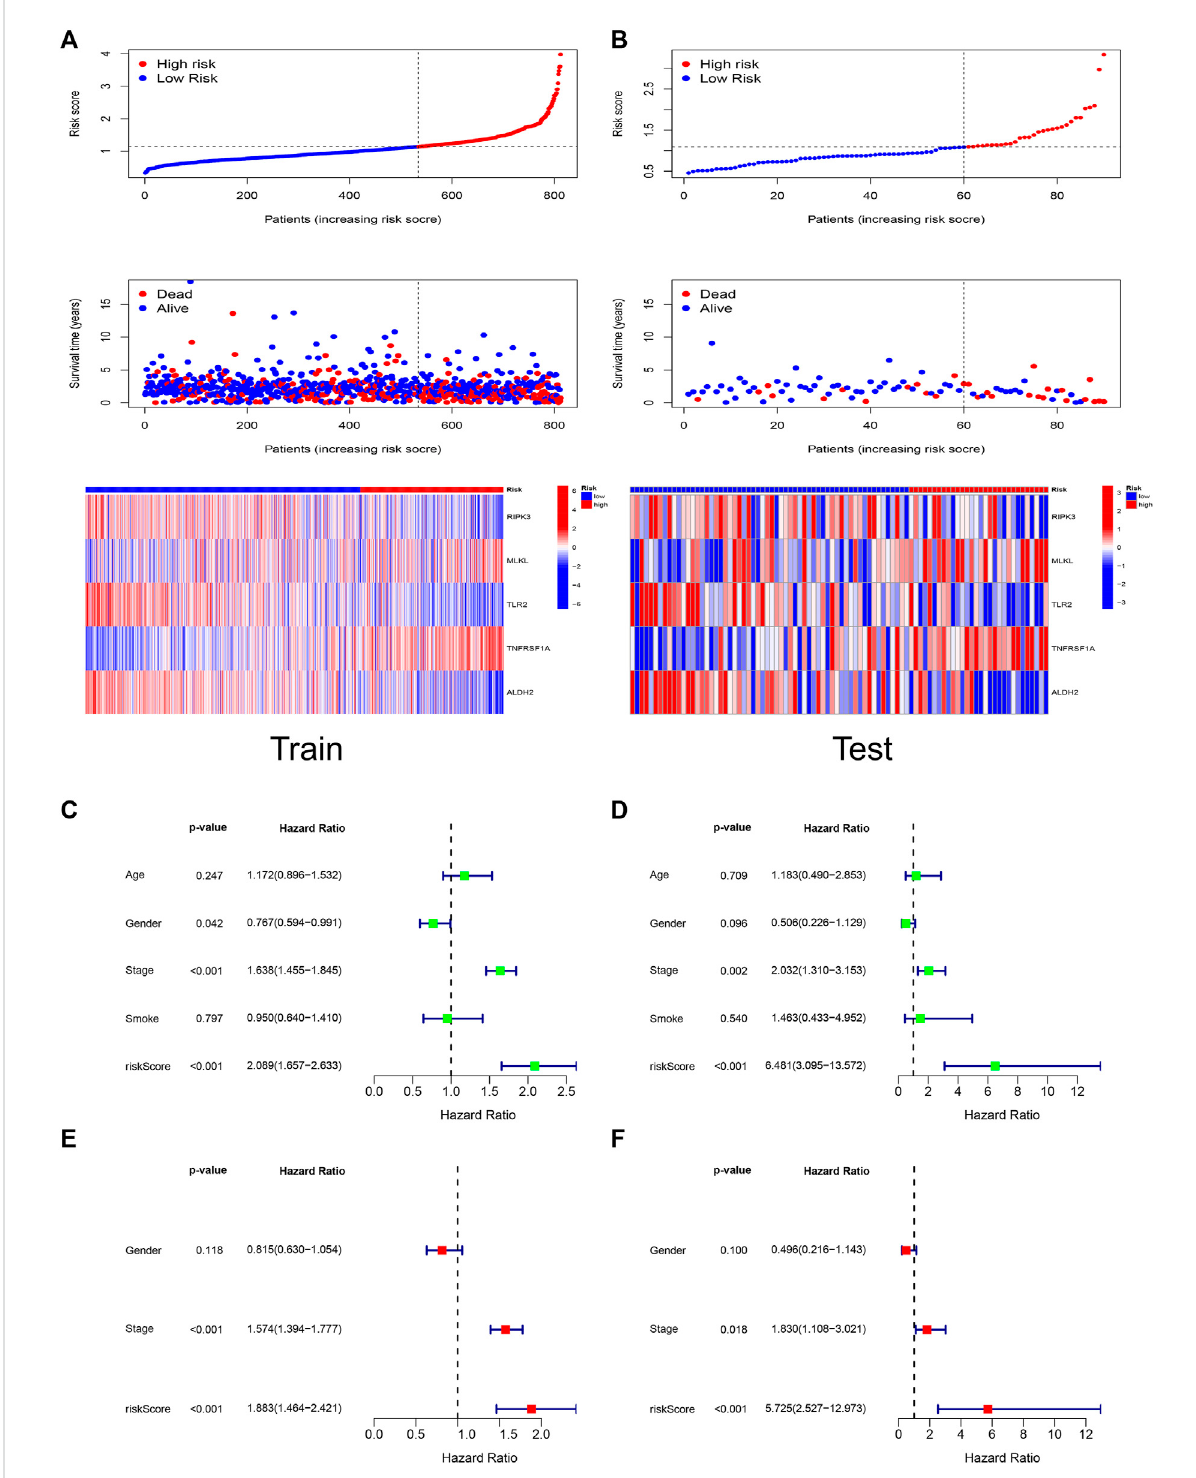
FIGURE 4 Risk score has independent prognostic signi fi cance. The trends of risk scores, the distribution of survival status, and the expression of the fi ve genes included in the signature in Train set (A) and Test set (B) . The prognostic ability and clinical characteristics of the signature were analyzed by univariate Cox regression (C) , multivariate Cox regression (E) in Train set and validated by univariate Cox regression (D) , multivariate Cox regression (F) in Test set. The fi ve-gene signature and stage were statistically signi fi cant in the Cox regression